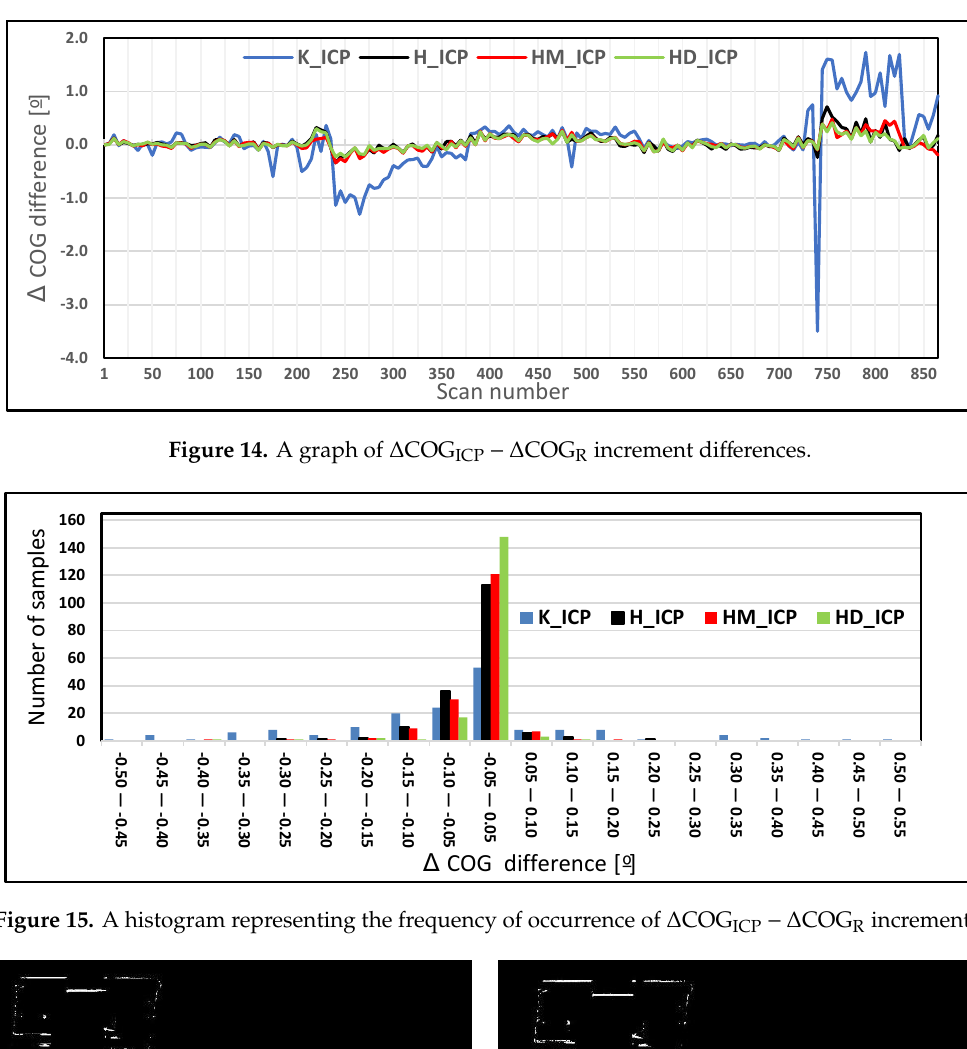
− ∆ COG ICP R increments.